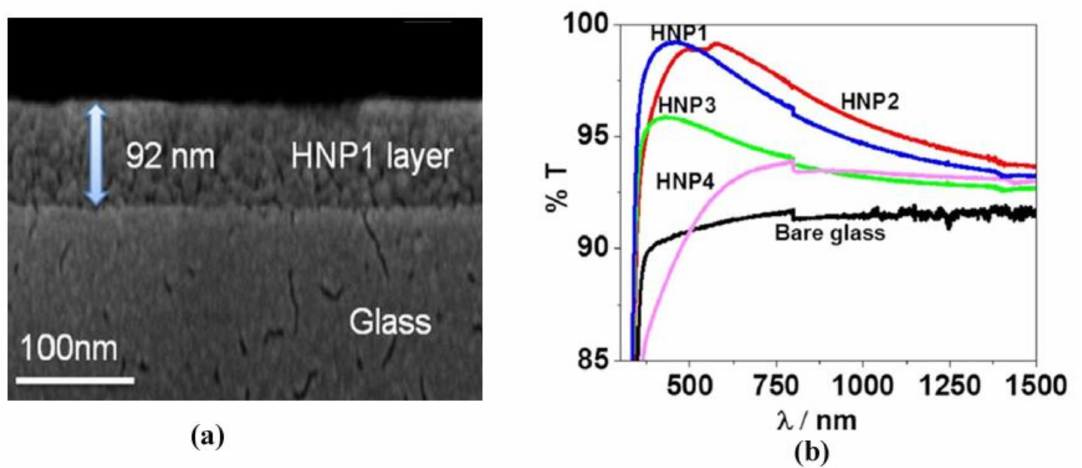
Figure 21. ( a ) FIB cross-sectional image of ARC consisting of hollow MgF 2 nanoparticles (HNP-1 layer). ( b ) Transmittance spectra of AR films comprised of di ff erent hollow nanoparticles. Reprinted with permission [185]; 2018,